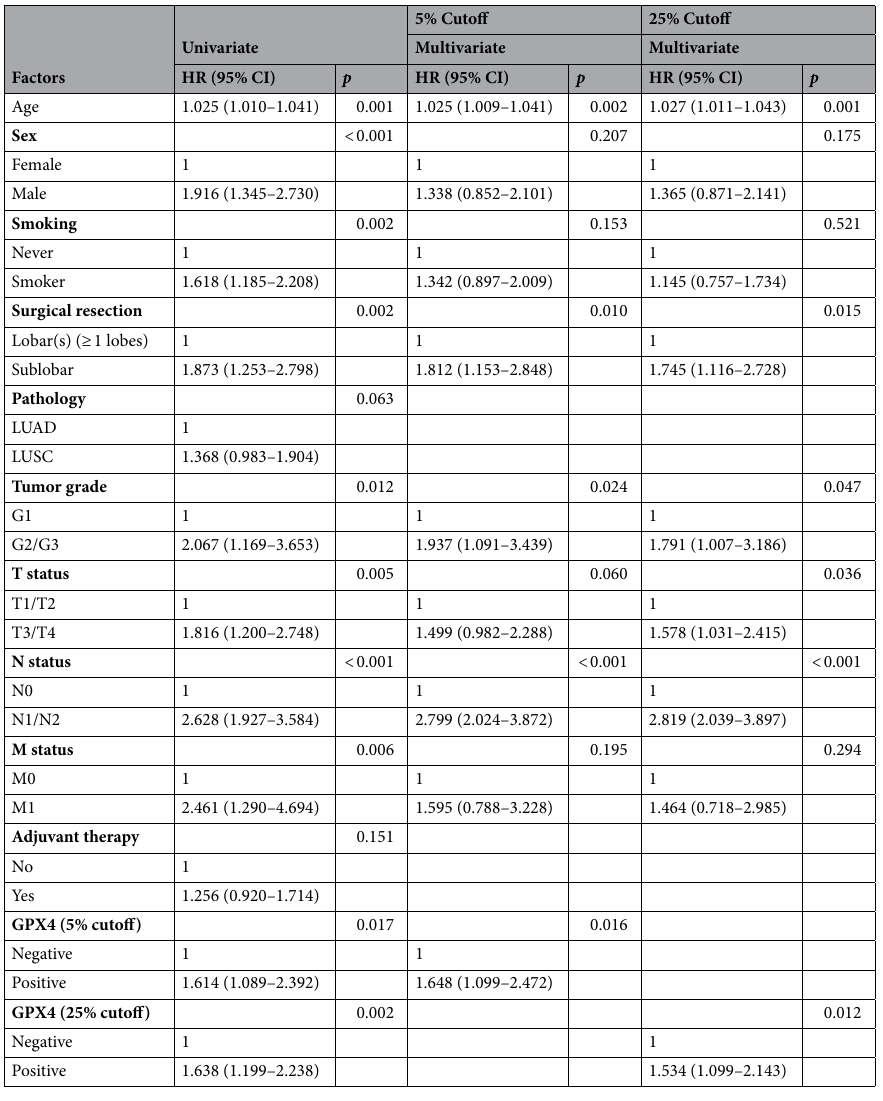
Table 3. Univariate and multivariate analysis of overall survival in resected NSCLC patients with the GPX4 protein expression at 5% and 25% cutoff values. NSCLC non-small cell lung cancer, HR hazard ratio, CI confidence interval, GPX4 glutathione peroxidase-4, T tumor, N nodes, M